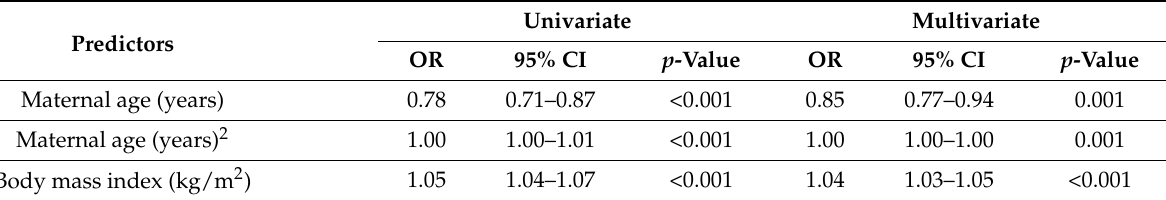
Table 2. Odds ratios obtained from logistic regression analysis demonstrating association of maternal race with